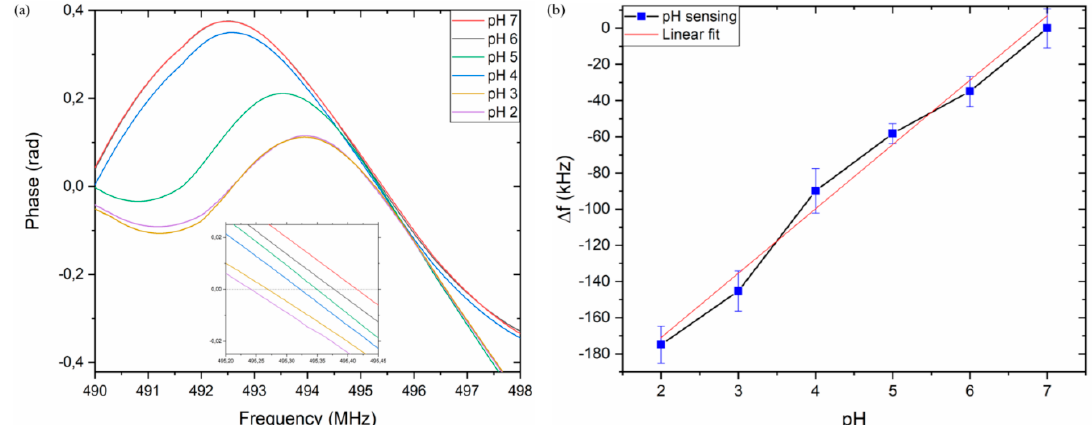
Figure 9. Phase change at different pH solutions, inset in figure shows a zoom of phase response ( a ); resonance frequency shift in response to different pH values ( b ).